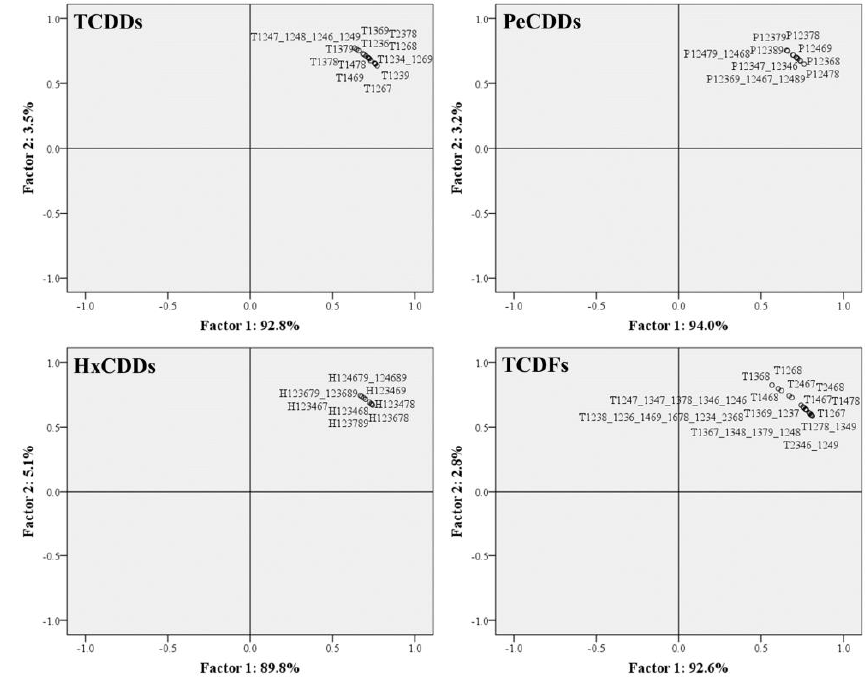
Figure 6. Principal component analysis (PCA) of CP-route congeners and the other isomers. Table 4. Hagenmaier profiles of 2,3,7,8-PCDD/F isomers (%) for leather waste incineration.